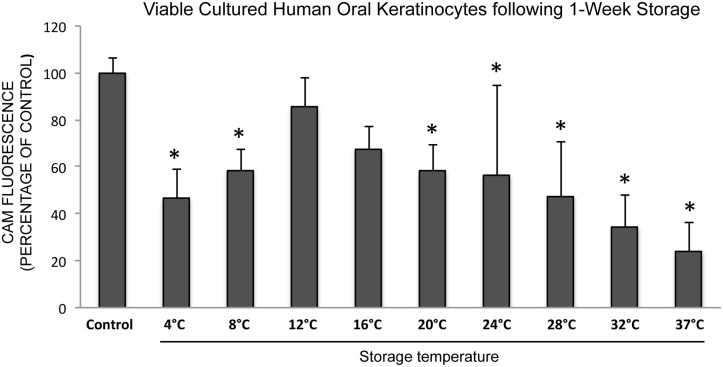
Cultured HOK were stored for seven days at nine different temperatures and viability was assessed by measuring calcein-acetoxymethyl ester (CAM) fluorescence with a microplate fluorometer.The bar chart illustrates the percentage of viable cells remaining after storage compared to control cells. (N = 5) * P < 0.05 compared to the control. Error bars indicate standard error of the mean.